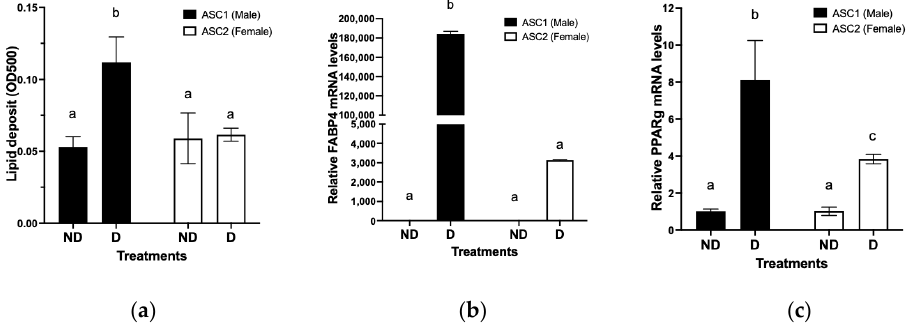
Figure 2. Differences in differentiation potential of individual adipose stem cells (ASCs). ASCs were cultured and differentiation potential was assessed by measuring Oil Red O staining of lipid deposit and differentiation marker genes PPAR-gamma and FABP4 mRNA levels as described in Materials and Methods. ( a ) Oil Red O staining of lipid deposit. Results are expressed as OD500 +/ − SD (n = 3). ( b ) FABP4 mRNA levels. Results are expressed as relative mRNA levels (Mean +/ − SD, n = 3) to non-differentiated ASC1. ( c ) PPAR-gamma mRNA levels. Results are expressed as relative mRNA levels (Mean +/ − SD, n = 3) to non-differentiated ASC1. ND: Non-differentiated. D: Differentiated. Bars with different letter indicate significantly different at p <